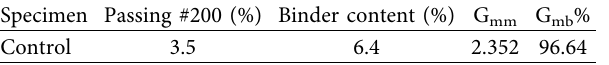
Table 5: Composition and volumetric properties of the control specimens.